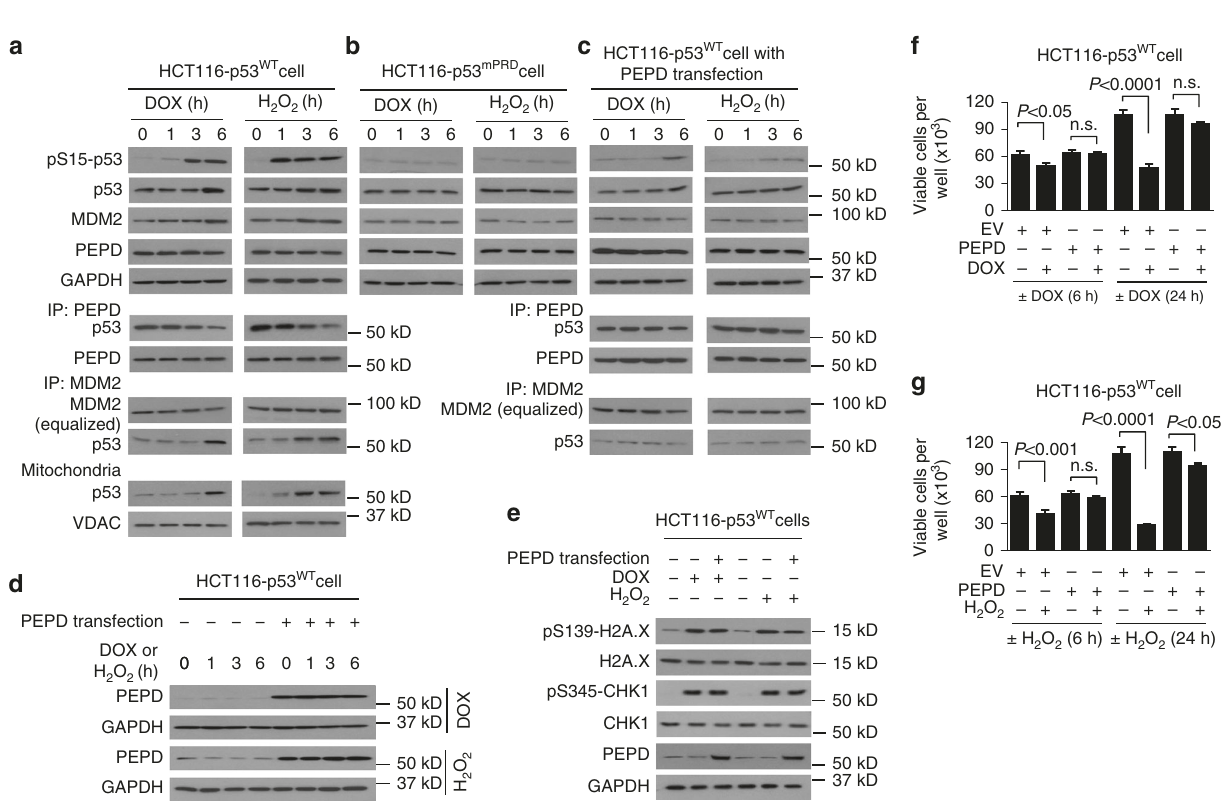
Fig. 8 p53 activation by stress relies on p53 separation from PEPD. a IB and IP-IB analysis of various proteins in cell lysates and mitochondria after cell treatment with DOX or H 2 O 2 . b IB analysis of various proteins in cells treated with DOX or H 2 O 2 . c IB and IP-IB analysis of various proteins in cells transfected with PEPD for 24 h and then treated with DOX or H 2 O 2 . d IB analysis of PEPD in cell samples from a and c . e IB analysis of H2A.X, CHK1 and PEPD in control cells, cells treated with DOX or H 2 O 2 for 6 h, or cells transfected with PEPD for 24 h and then treated with DOX or H 2 O 2 for 6 h. f , g Measurement of cell viability. Cells were cultured in 12-well plates (2 × 10 4 cells/well) for 24 h, transfected with EV or PEPD, and 24 h later treated with DOX, H 2 O 2 or solvent for 6 h or 24h. Data are means ± s.d. ( n = 3); two-way ANOVA followed by Tukey multiple comparisons test; n.s.; not signi fi cant. GAPDH and VDAC were measured as loading controls. DOX and H 2 O 2 were used in all experiments at 400 nM and 400 μ M,